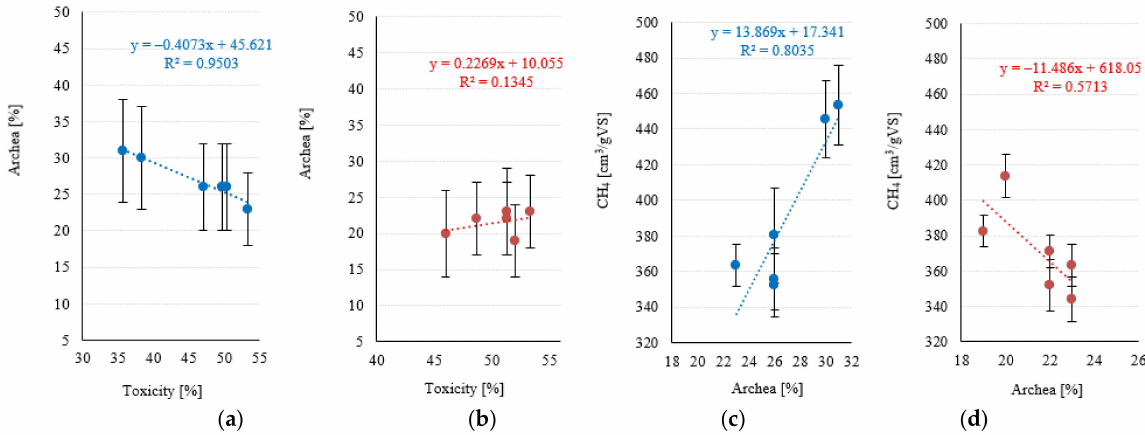
Figure 12. Correlations between toxicity and the share of Archaea ( a ) series 1, ( b ) series 2; the share of Archaea and methane levels ( c ) series 1, ( d ) series 2.